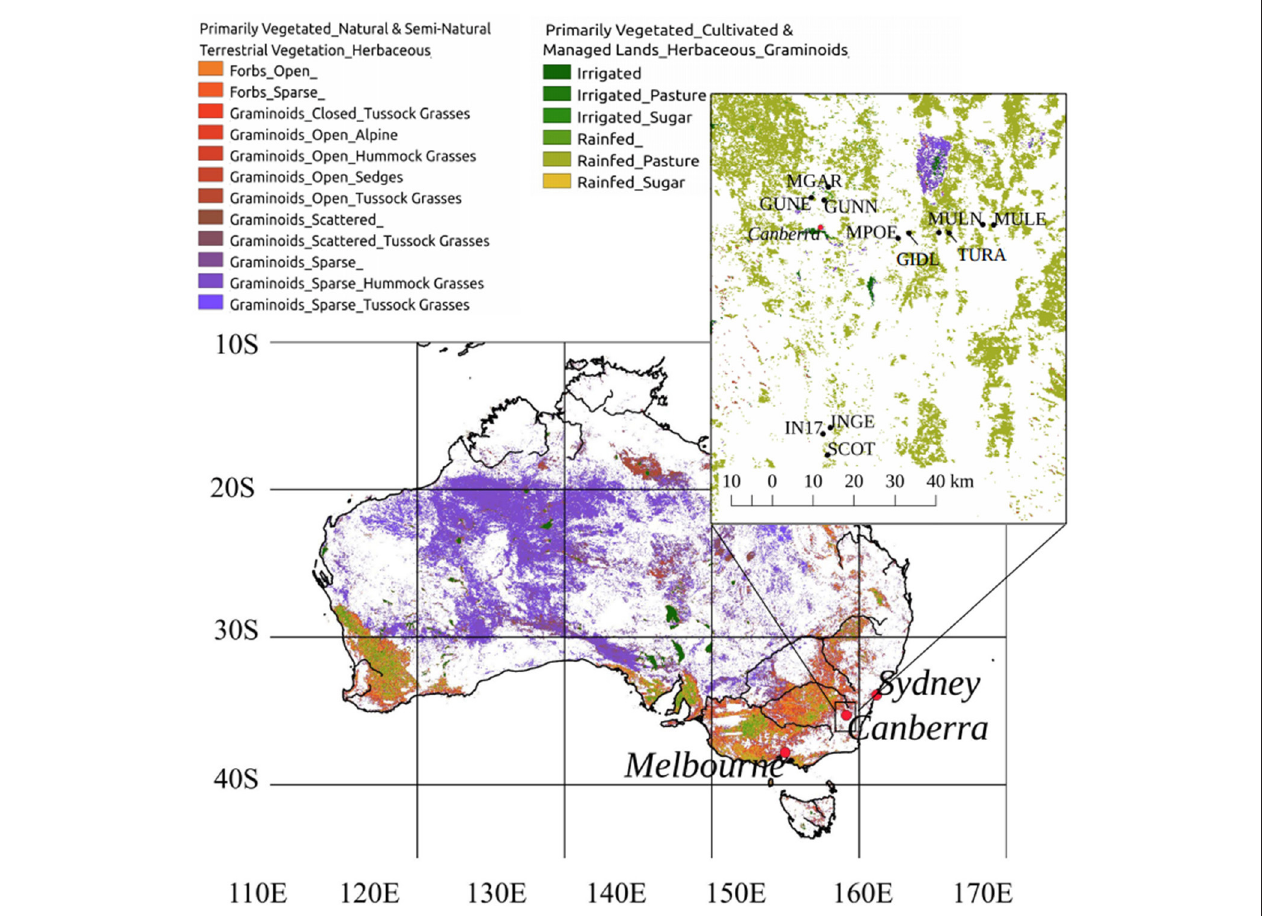
FIGURE 1 | Location of study area, south east of the continent, near the city of Canberra, Australia. Background vegetation mapping refers to the Dynamic Land Cover Dataset ( Lymburner et al., 2011). Inset shows the location of individual study sites.